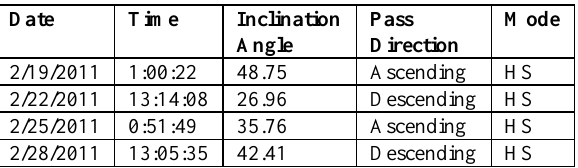
Figure 9. Acquisition plan for satellite passes